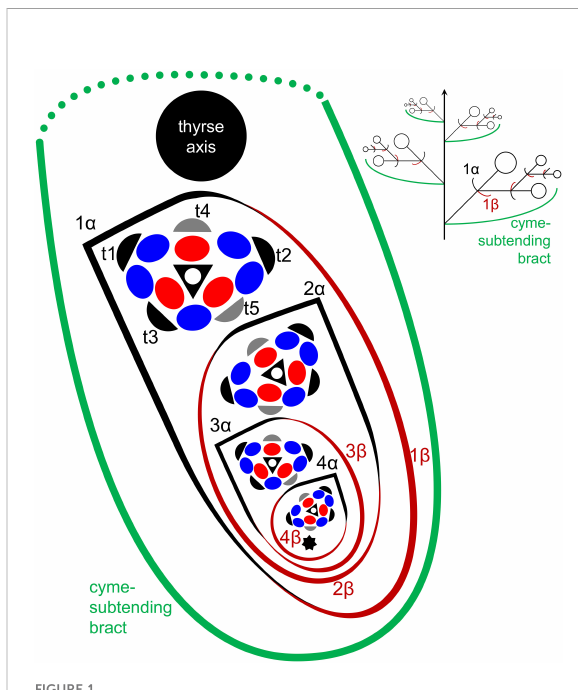
FIGURE 1 Flower, cyme and thyrse diagrams of Fagopyrum esculentum. Left, diagrammatic cross section of cyme with fl owers of four successive orders and an incipient fi fths fl ower (asterisk). a (black) and b (brown), two fused prophylls. Numbers before a and b indicate axis order within the cyme. t1-t5, tepals in in order of their inferred (pre)patterning. Two last-formed tepals are grey. Blue, outer whorl stamens; red, inner whorl stamens. Right, diagrammatic side view of thyrse with four cymes. Open circles, fl owers. Cyme-subtending bract (green) is fi rst narrow, but its base encircles the stem late in ontogeny (dotted